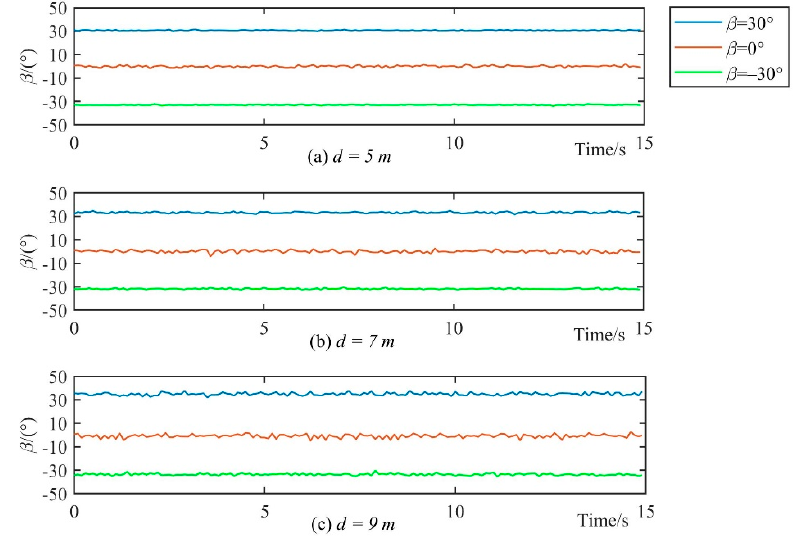
Figure 15. Detection of steady-state performance. Table 1. Fixed-angle fluctuation